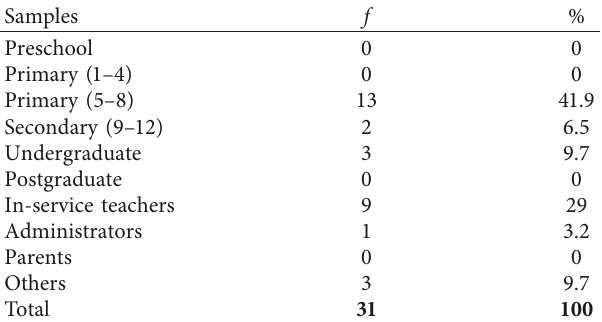
Table 8: Frequently used samplings in IBL studies in Ethiopia (2010 to 2021).